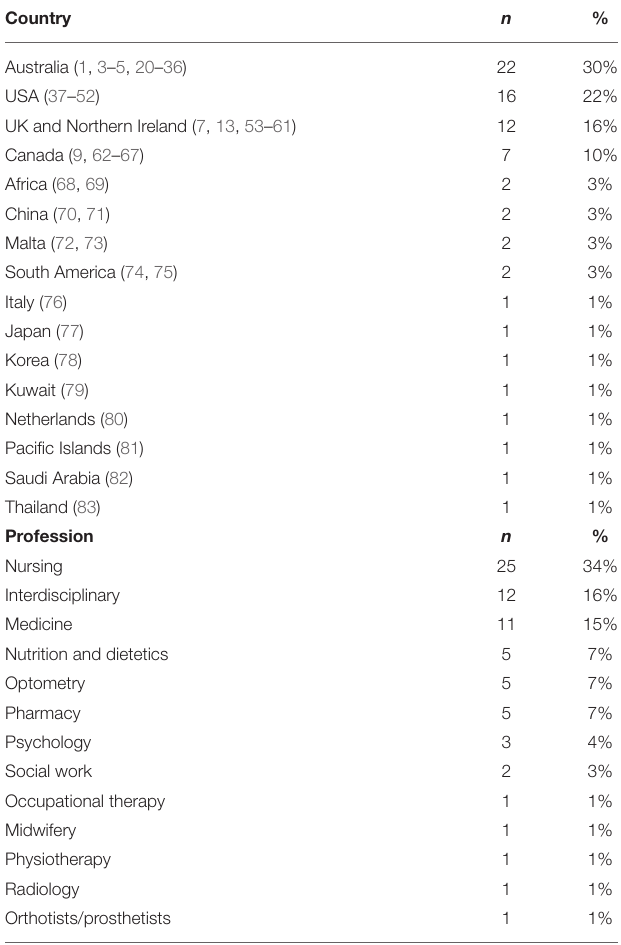
TABLE 2 | Study locations and profession characteristics of included studies ( n = 73).